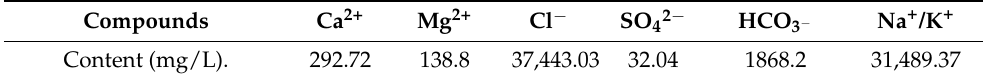
Table 2. Chemical composition of simulated formation water (mg/L).